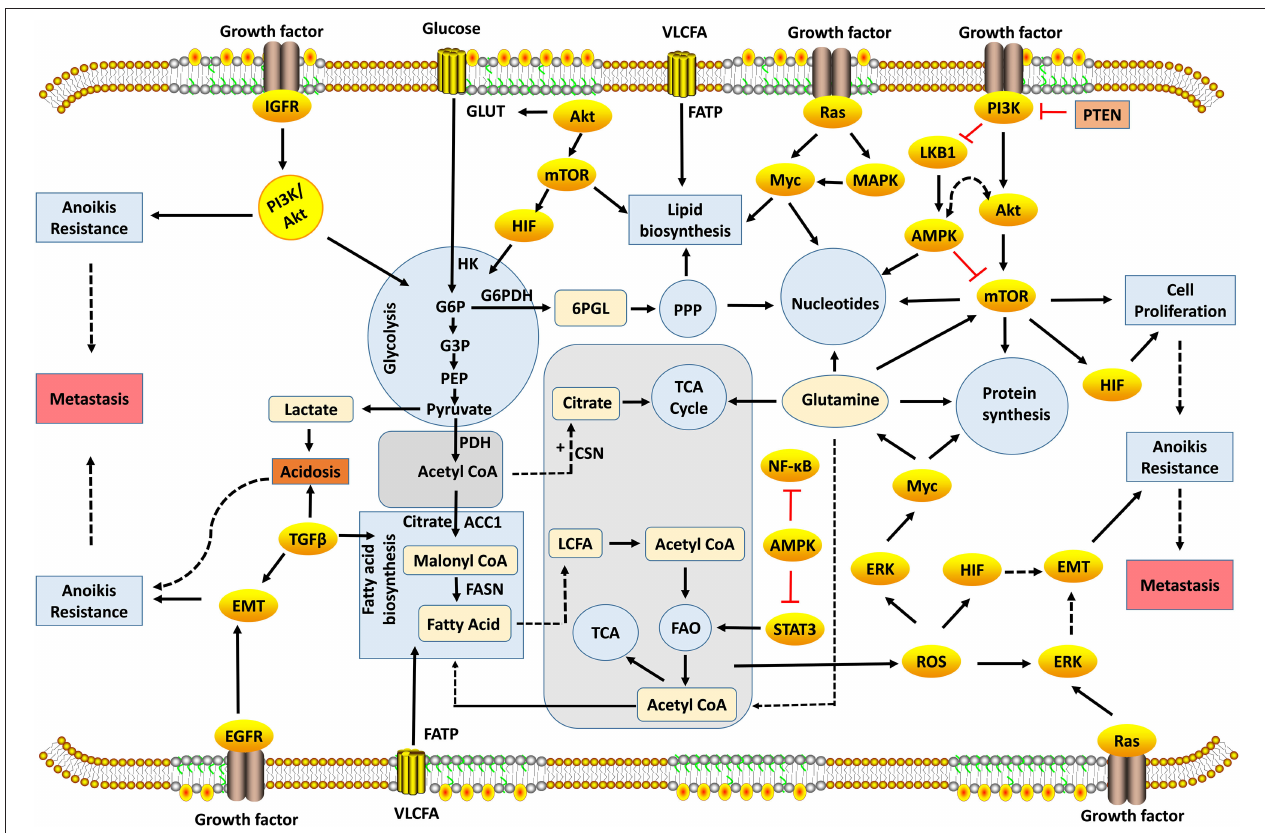
FIGURE 2 | Metabolic and signaling networks involved in anoikis-resistance mechanism. Several metabolic intermediates generate the energy required for cellular growth and survival; oncogenic activation of signaling pathways reprogram cellular metabolism to promote anoikis resistance. Metabolic pathways occur in different compartments, which involve the biosynthesis or degradation of biomolecules to supply energy needs of the cell. Glycolysis, PPP, protein, fatty acid, and nucleotide biosynthesis take place in the cytosol, while TCA and FAO occur in the mitochondria. The decarboxylation of pyruvate to acetyl-CoA takes place in the mitochondrial matrix. These metabolic pathways are interrelated with acetyl-CoA, which acts a key substrate for connecting these pathways. Metabolism is regulated by rate-limiting enzymes that allow the cell to maintain cellular homeostasis. However, the dysregulation of genes encoding these enzymes leads to metabolic perturbation that drives anoikis resistance preceding tumor metastasis. 6PGL, 6-Phosphogluconolactone; AMPK, Adenosine Monophosphate Kinase; ACC1, Acetyl Carboxylase 1; ATP, Adenosine Triphosphate; CSN, Citrate Synthase; EGFR, Epidermal Growth Factor Receptors; EMT, Epithelial-Mesenchymal Transition; ERK, Extracellular-Signal-Regulated Kinase; FAO, Fatty Acid Oxidation; FASN, Fatty Acid Synthase; FATP, Fatty Acid Transport Proteins; G3P, Glyceraldehyde-3-Phosphate; G6P, Glucose-6-Phosphate; G6PDH, Glucose-6-Phosphate Dehydrogenase; GLUT, Glucose Transporters; HIF, Hypoxia-Inducible Factors; HK, Hexokinase; IGFR, Insulin-Like Growth Factor-1 Receptor; LKB1, Liver Kinase B1; MAPK, Mitogen-Activated Protein Kinase; mTOR, Mammalian Target of Rapamycin; NF- κ B, Nuclear Factor-Kappa B; PDH, Pyruvate Dehydrogenase; PEP, Phosphoenolpyruvate; PI3K, Phosphatidylinositol 3-Kinase; PPP, Pentose Phosphate Pathway;